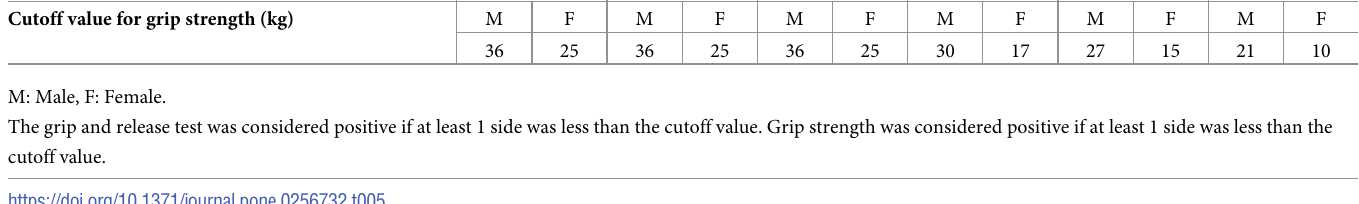
the left and right hands. The subject was asked to grip and release the fingers (i.e., full finger flexion and extension) as rapidly as possible, and the number of movement cycles completed within 10 seconds was counted [15,39,40]. Grip strength of the left and right hands was